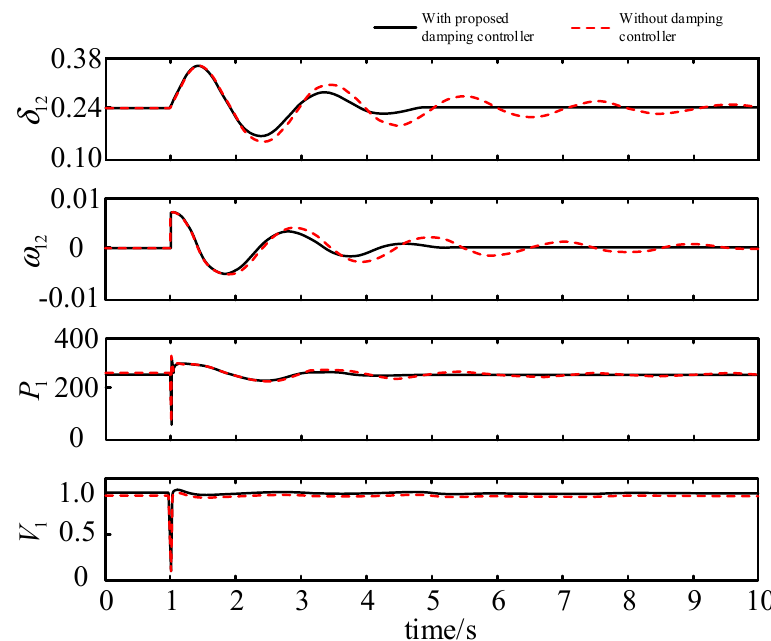
Figure 6. The dynamic reaction of line in case of a malfunction in bus 1.